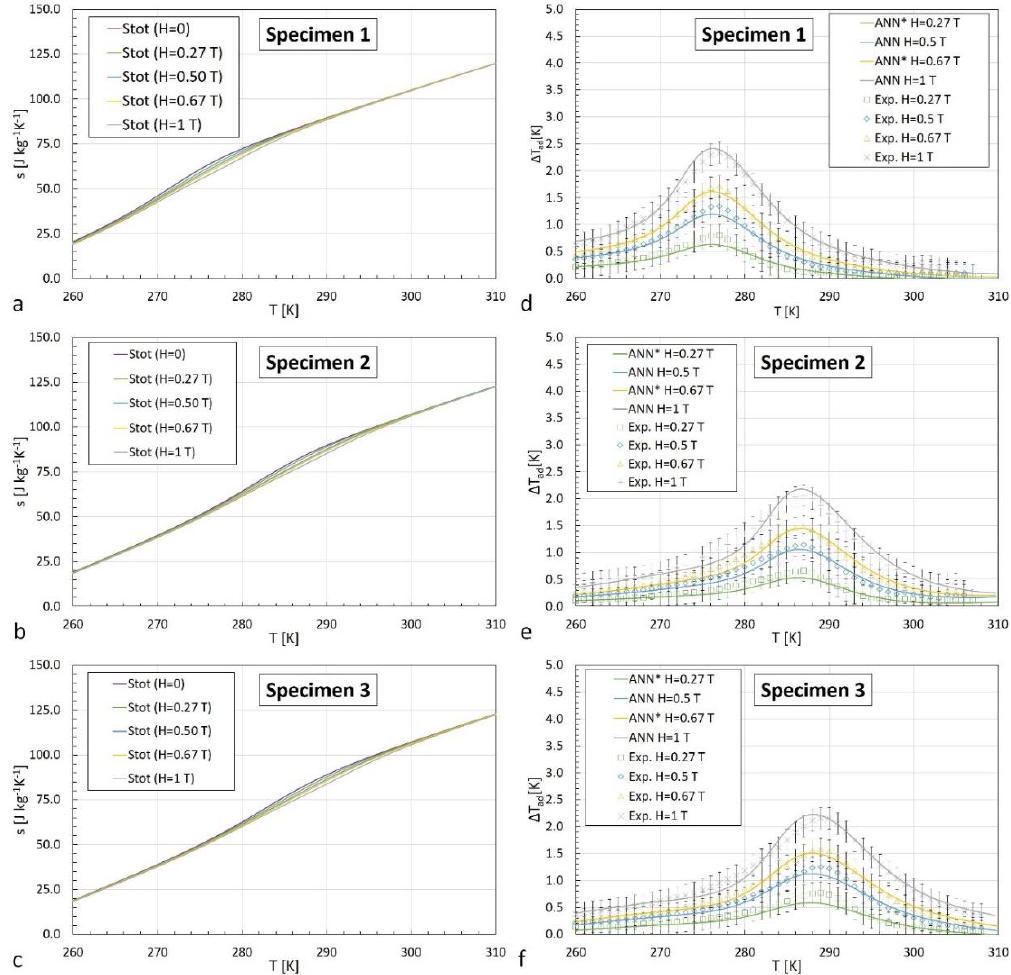
Figure 9. Results of the last step of the procedure: ( a – c ) s - T diagram of the three samples of La-Fe-Co-Si alloy and ( d – f ) adiabatic temperature change of the three samples of La-Fe-Co-Si alloy during the magnetisation phase at different magnetic fields. The asterisk in the legend indicates an applied magnetic field not included in the training dataset.